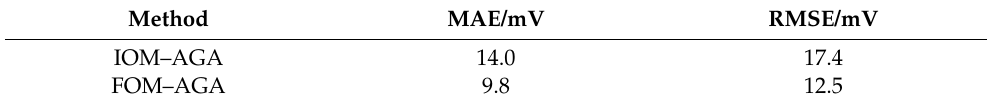
Table 2. Voltage error comparison.